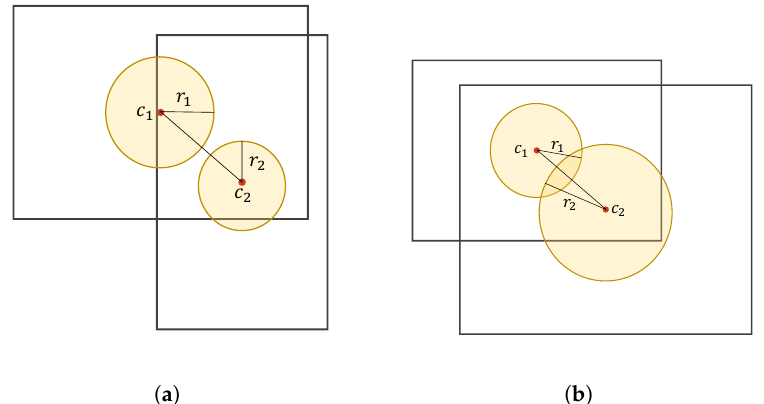
Figure 3. SchematicofDBC-NMSalgorithm. ( a ) Case of two bounding boxes for independent objects. ( b ) Case including the mispredicted bounding